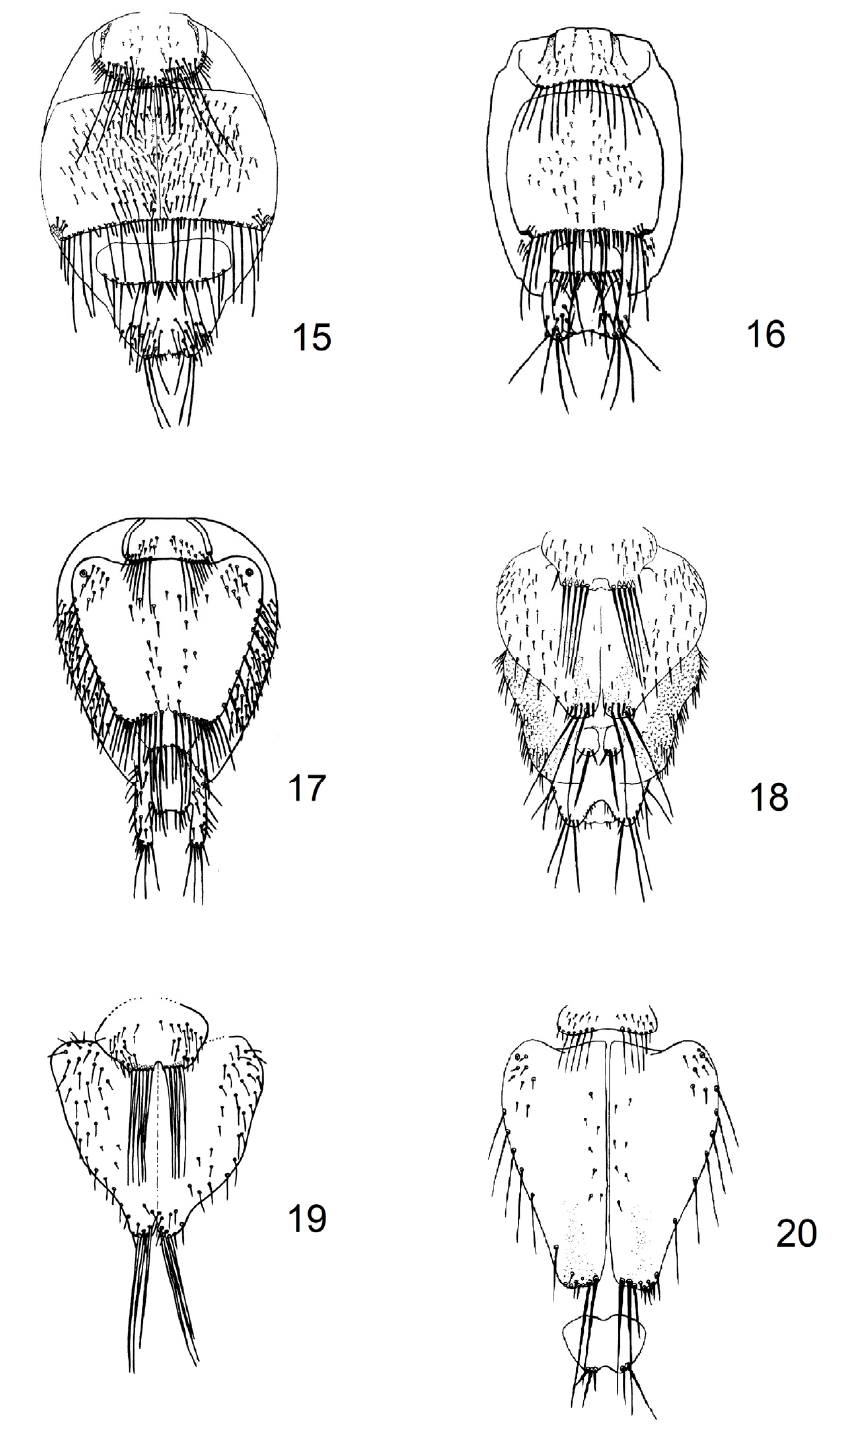
Figure 2. ( 15 ) Basilia nattereri Kolenati, 1857, female, abdomen; ( 16 ) Basilia nana Theodor and Moscona, 1954, female, abdomen; ( 17 ) Basilia italica Theodor, 1954, female, abdomen; ( 18 ) Basilia daganiae Theodor and Moscona, 1954, female, abdomen; ( 19 ) Basilia mediterranea Hurka, 1970, female, abdomen; ( 20 ) Basilia mongolensis nudior Hurka, 1972, female, abdomen.